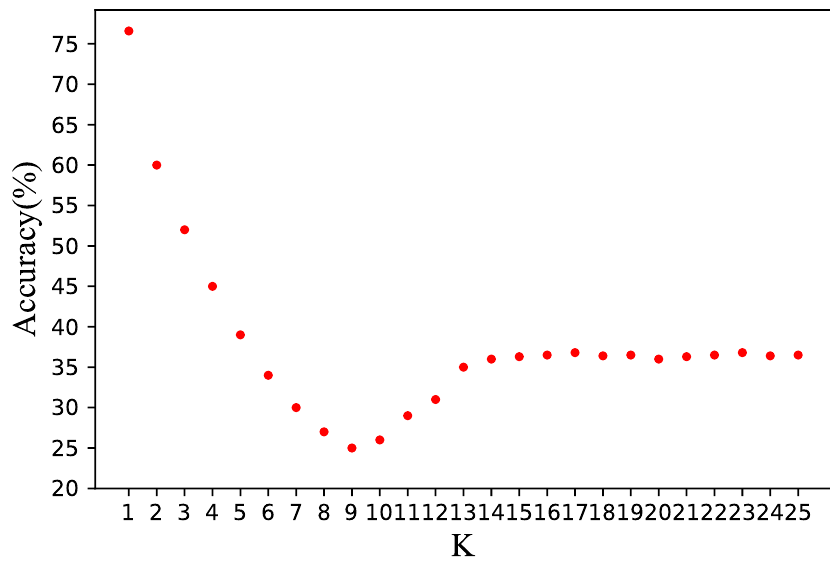
Figure 6. The accuracy of the KNN algorithm with K varying.